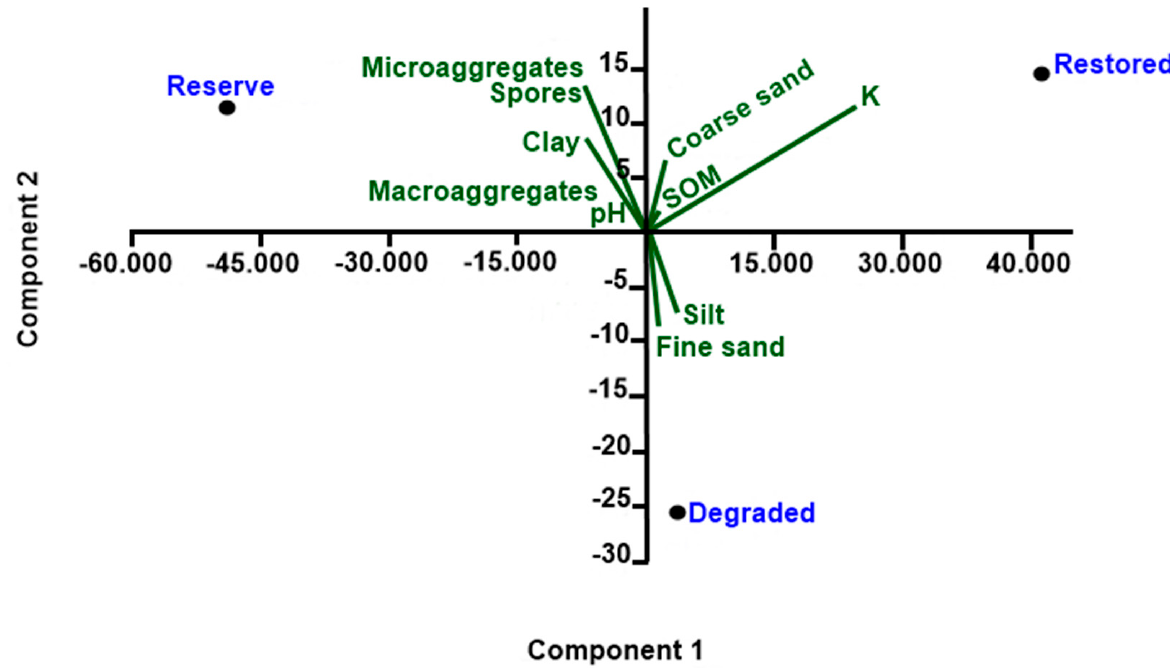
Figure 4. Ordination diagram resulting from principal component analysis (PCA) between the physico-chemical properties (coarse and fine sand, pH, potassium (K), phosphorus (P), and soil organic matter (SOM), soil aggregation of the soils from preserved, restored, and degraded riparian sites, and AMF spore number.